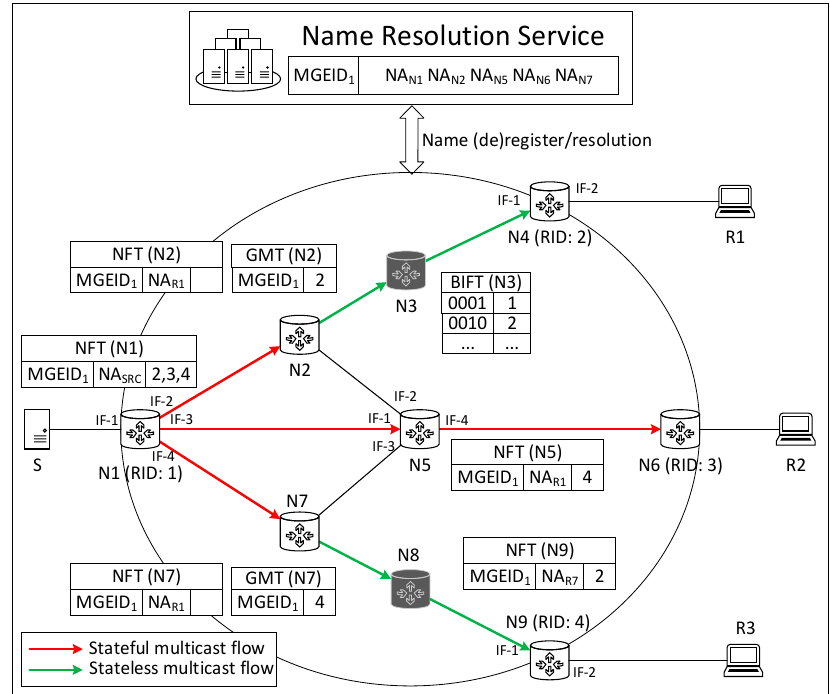
Figure 1. An example of the adaptive hierarchical hybrid multicast system.